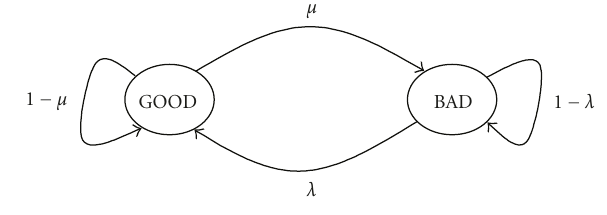
Figure 6: 2-state Markov channel